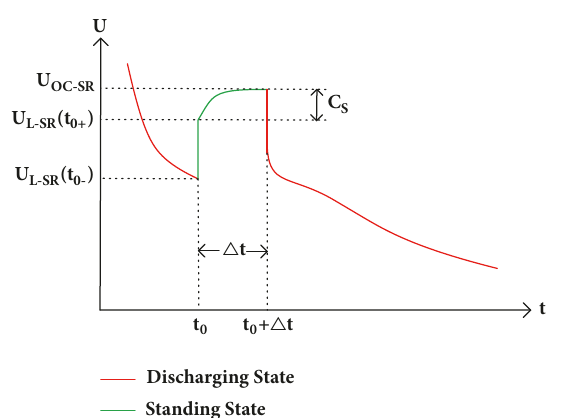
Figure 5: Self-healing test